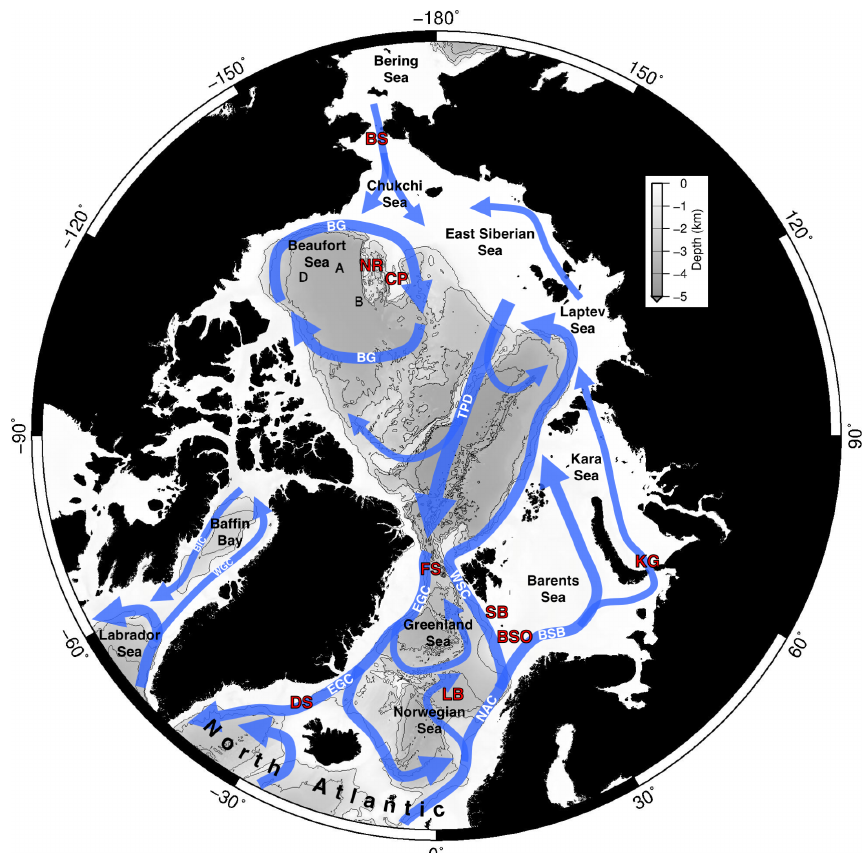
Figure 1. Map of the Arctic Ocean and surrounding seas with a schematic of the ocean surface circulation (blue arrows). Depth contours are drawn every 1km and are taken from the ETOPO1 global bathymetry model (Amante and Eakins, 2009). Bathymetric features mentioned in the text are labelled in red, with the following abbreviations: BS, Bering Strait; NR, Northwind Ridge; CP, Chukchi Plateau; FS, Fram Strait; BSO, Barents Sea Opening; SB, Svalbard Bank; KG, Kara Gate; LB, Lofoten Basin; DS, Denmark Strait. Specific currents mentioned in the text are labelled white, with the following abbreviations: BG, Beaufort Gyre; TPD, Transpolar Drift; WSC, West Spitsbergen Current; EGC, East Greenland Current; WGC, West Greenland Current; BIC, Baffin Island Current; NAC, Norwegian Atlantic Current; BSB, Barents Sea Branch. Beaufort Gyre Exploration Project moorings A, B and D are labelled in